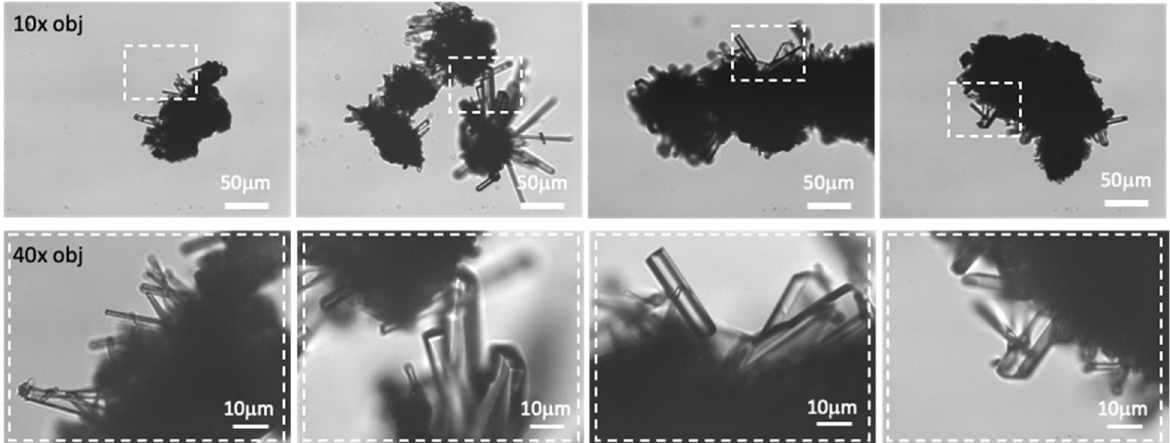
Fig. 15 Optical microscope images of the dry heat-treated powder, showing, presumably, anhydrous recrystallization using 10 (bottom) objectives. Regions of interest are shown at the two magnifications by the dashed boxes. Scale bars are 50 μm and 10 μm in bright field Kohler illumination optics (Nikon